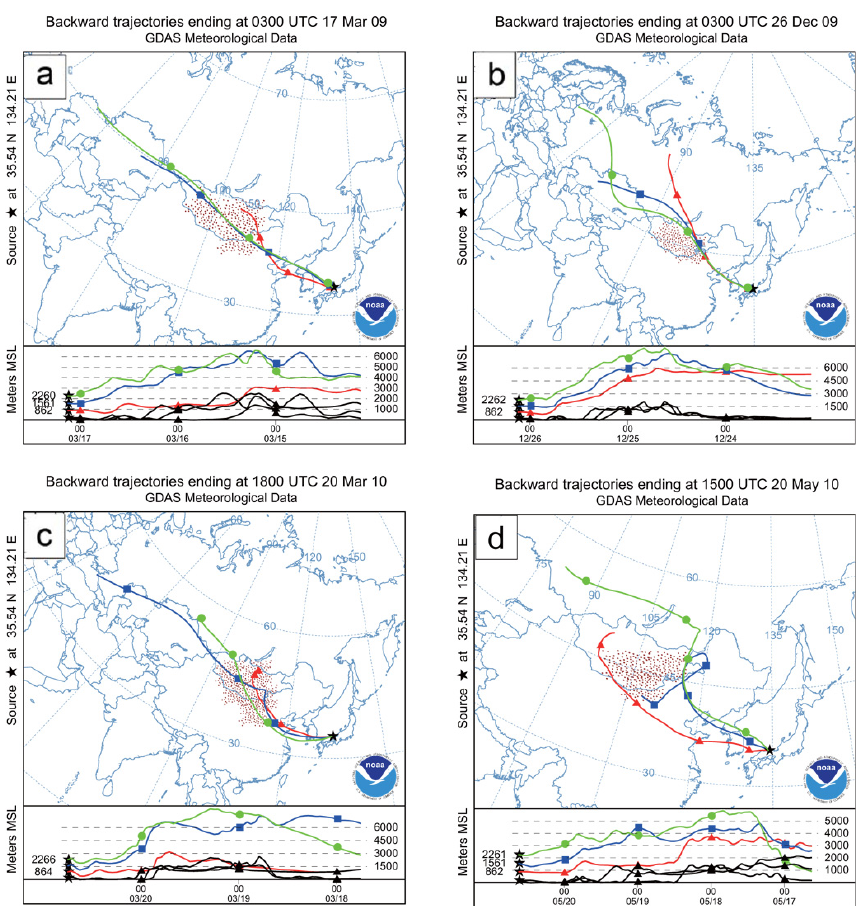
Fig. 10. ( a , b , and c ) 72h and (d) 96h backward trajectories of air masses for events in Fig. 7, starting at 700 (red), 1400 (blue), and 2100 (green) m above ground level over Tottori using the HYSPLIT model (Draxler and Rolph, 2013, http://ready.arl.noaa.gov/HYSPLIT.php). Symbols of trajectories denote positions at 00:00UT. The brown dotted area represents low visibility (dust storm) area based on the WMO SYNOP observations (http://www.nrlmry.navy.mil/aerosol/).